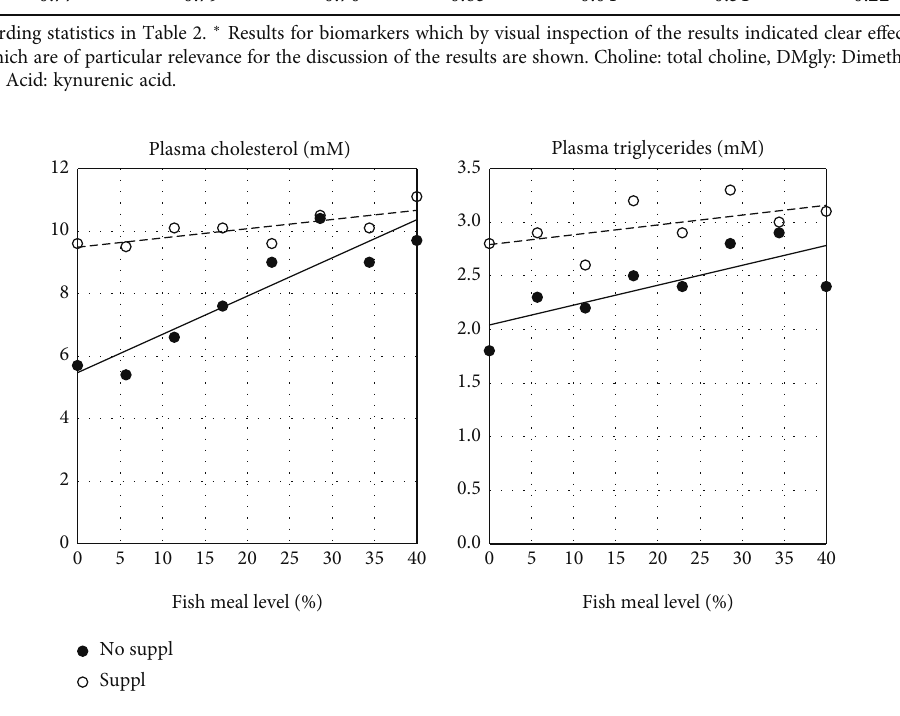
Figure 8: Results of analyses of plasma biomarkers which showed signi fi cant e ff ects of dietary fi shmeal level and of supplementation (No suppl vs. Suppl). For statistics, see Table